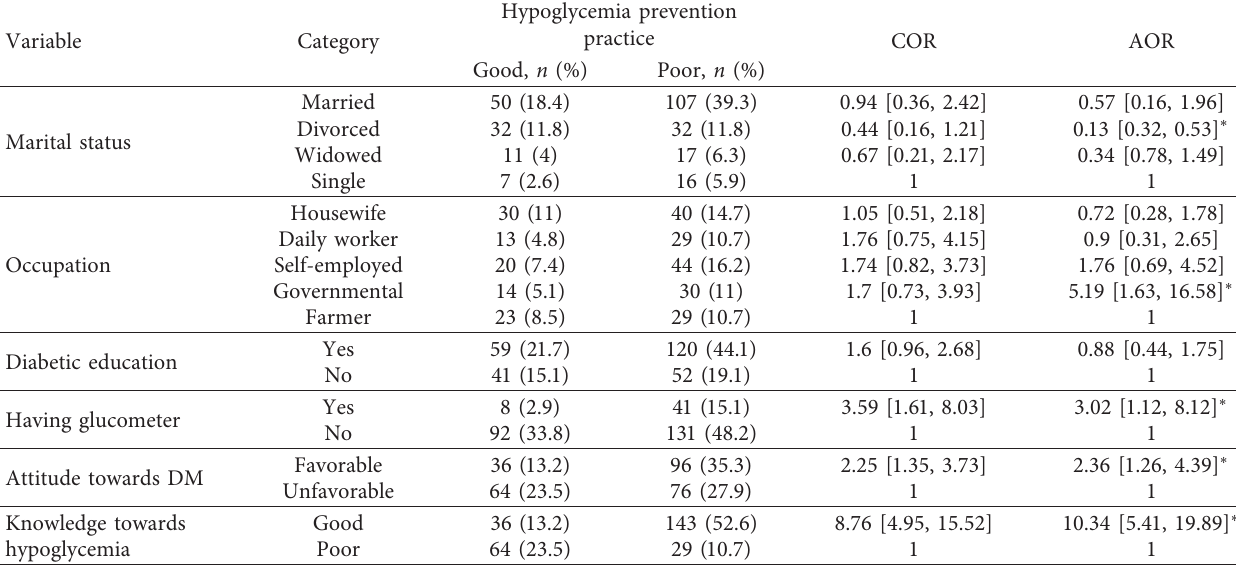
Table 3: Bivariate and multivariable logistic regression analysis result of significant variables among patients with diabetes mellitus at public hospitals of the central zone of Tigray, Ethiopia in